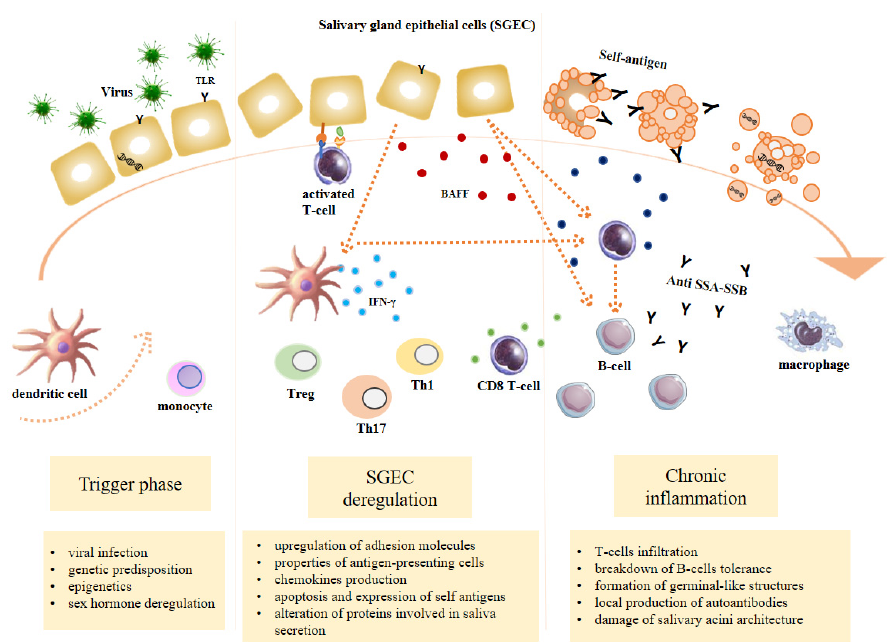
Figure 1. Overview of physiopathological mechanism underlying Sjögren’s syndrome (SS).